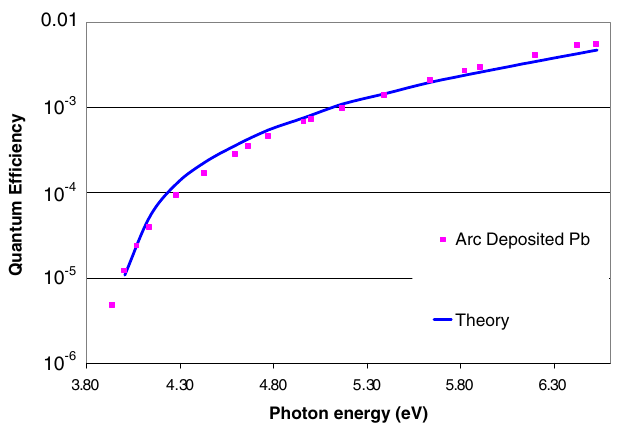
FIG. 10. (Color) Comparison between predicted and measured QE for arc-deposited lead.